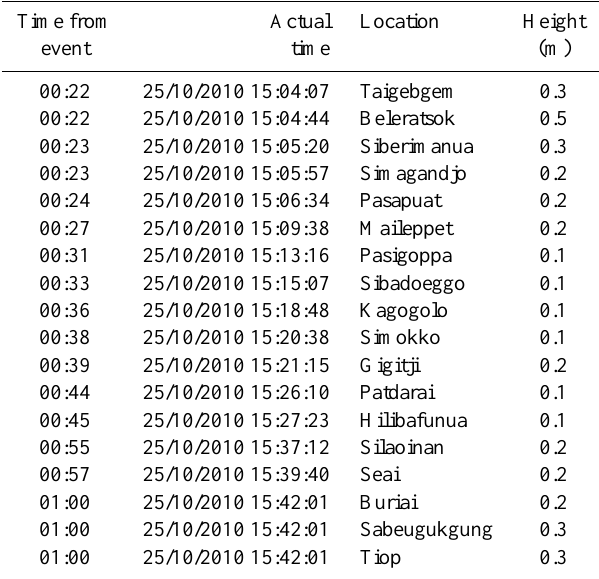
Fig. 10. Sibugau Island and South Pagai coast (ReliefWeb, 2011). Table 4. The first listed arrival times and maximum heights re- trieved from the pre-calculated database by using the preliminary results of